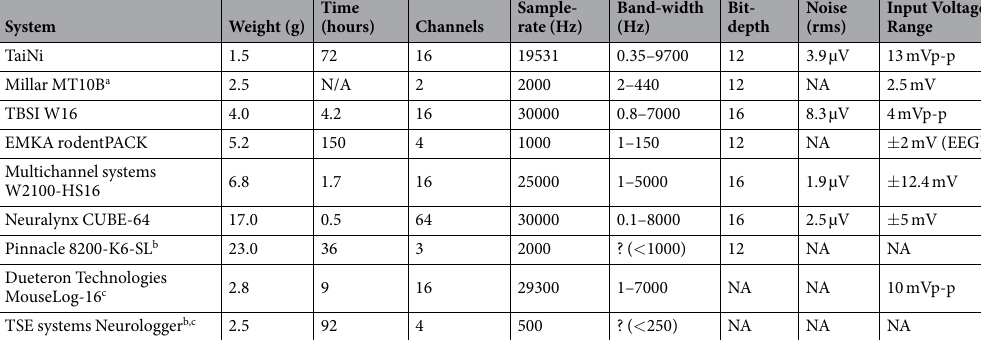
Table 1. A comparison of telemetry systems for electrophysiology. a Inductive charging system (no maximum recording time). b Band-width was not specified in available materials, and is inferred. c Data-logger systems (no